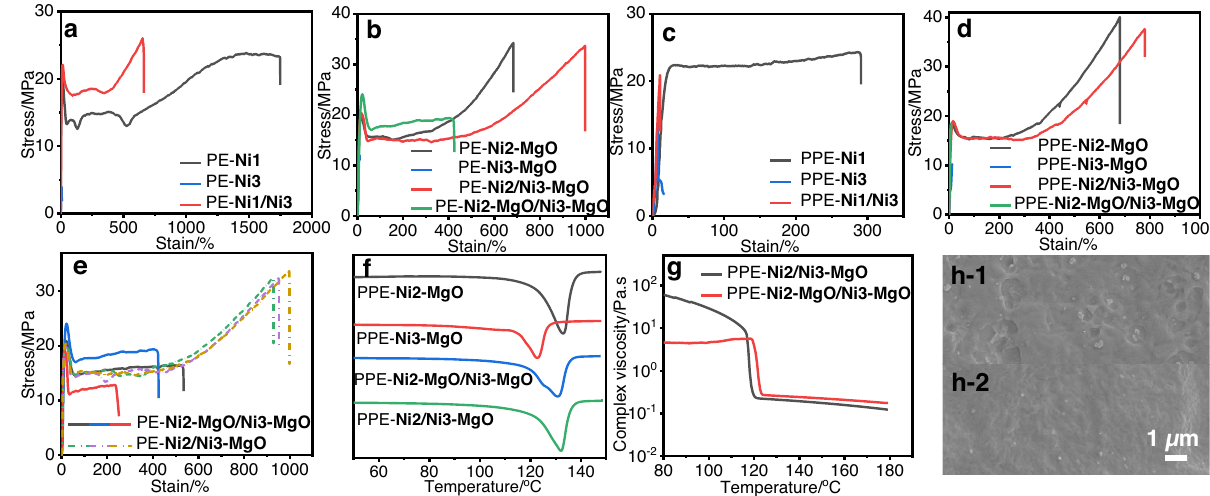
Fig. 3 | Comparison of bimodal polyethylene prepared in different systems. a Tensilecurvesofpolyethylenepreparedbyhomogeneouspolymerization.PE- Ni1 (Supplementary Table 1, Entry 1), PE -Ni3 (Supplementary Table 1, Entry 3), PE -Ni1/ Ni3 (SupplementaryTable1,Entry17). b Tensilecurvesofpolyethylenepreparedby heterogeneous polymerization. PE- Ni2-MgO (Supplementary Table 1, Entry 5), PE- Ni3-MgO (Supplementary Table 1, Entry 6), PE- Ni2/Ni3-MgO (Supplementary Table 1, Entry 16), PE- Ni2-MgO/Ni3-MgO (Supplementary Table 1, Entry 18). c Ten- sile curves of polar polyethylene prepared by homogeneous polymerization. PPE - Ni1 (SupplementaryTable3,Entry1),PPE -Ni3 (SupplementaryTable3,Entry3),and PPE -Ni1/Ni3 (Supplementary Table 3, Entry 4). d Tensile curves of polar